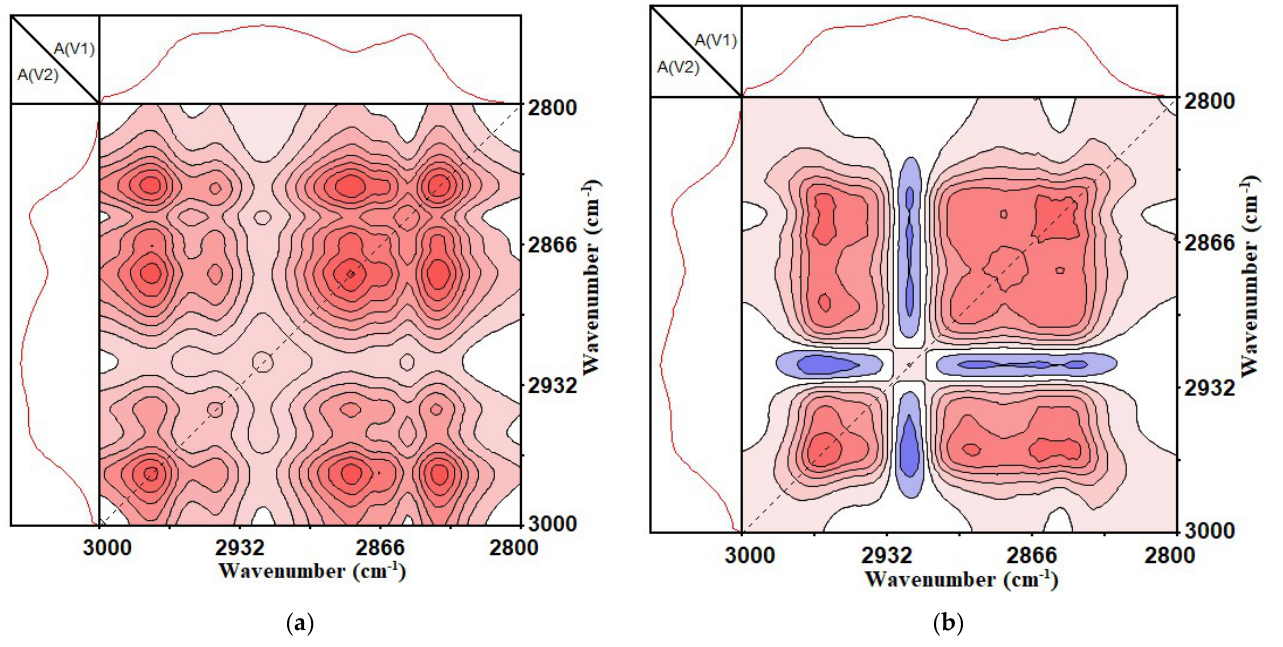
Figure 7. Two-dimensional synchronous infrared correlation spectrum of 3000~2800 cm − 1 . ( a ) SBS-modified asphalt binder; ( b ) SBS + 1% CNTs composite-modified asphalt binder.